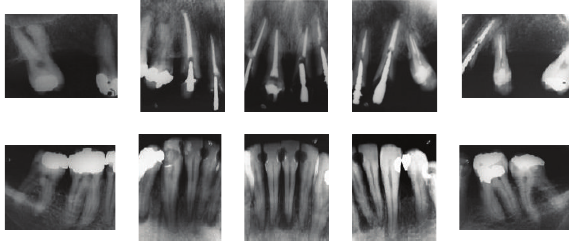
Figure 2: Pretreatment periapical